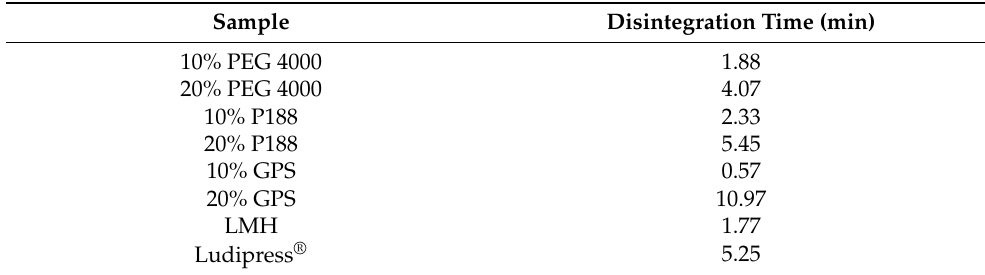
Table 5. Disintegration time of compacts prepared by compression of co-processed mixtures, LMH and Ludipress ® at compression pressure of 173.5